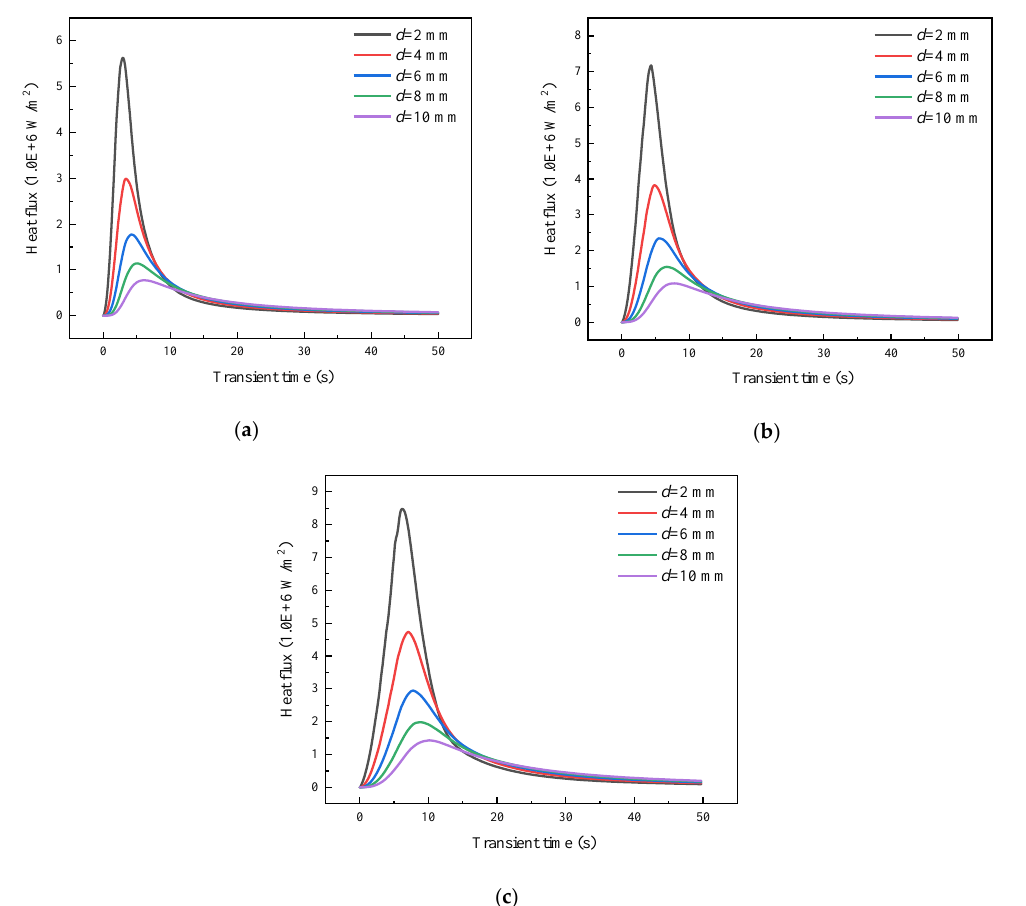
Figure 25. Heat flux distribution through crack surfaces in the HAZ for three different linear energy values: ( a ) Q = 10 kJ/cm; ( b ) Q = 16 kJ/cm; ( c ) Q = 25 kJ/cm.